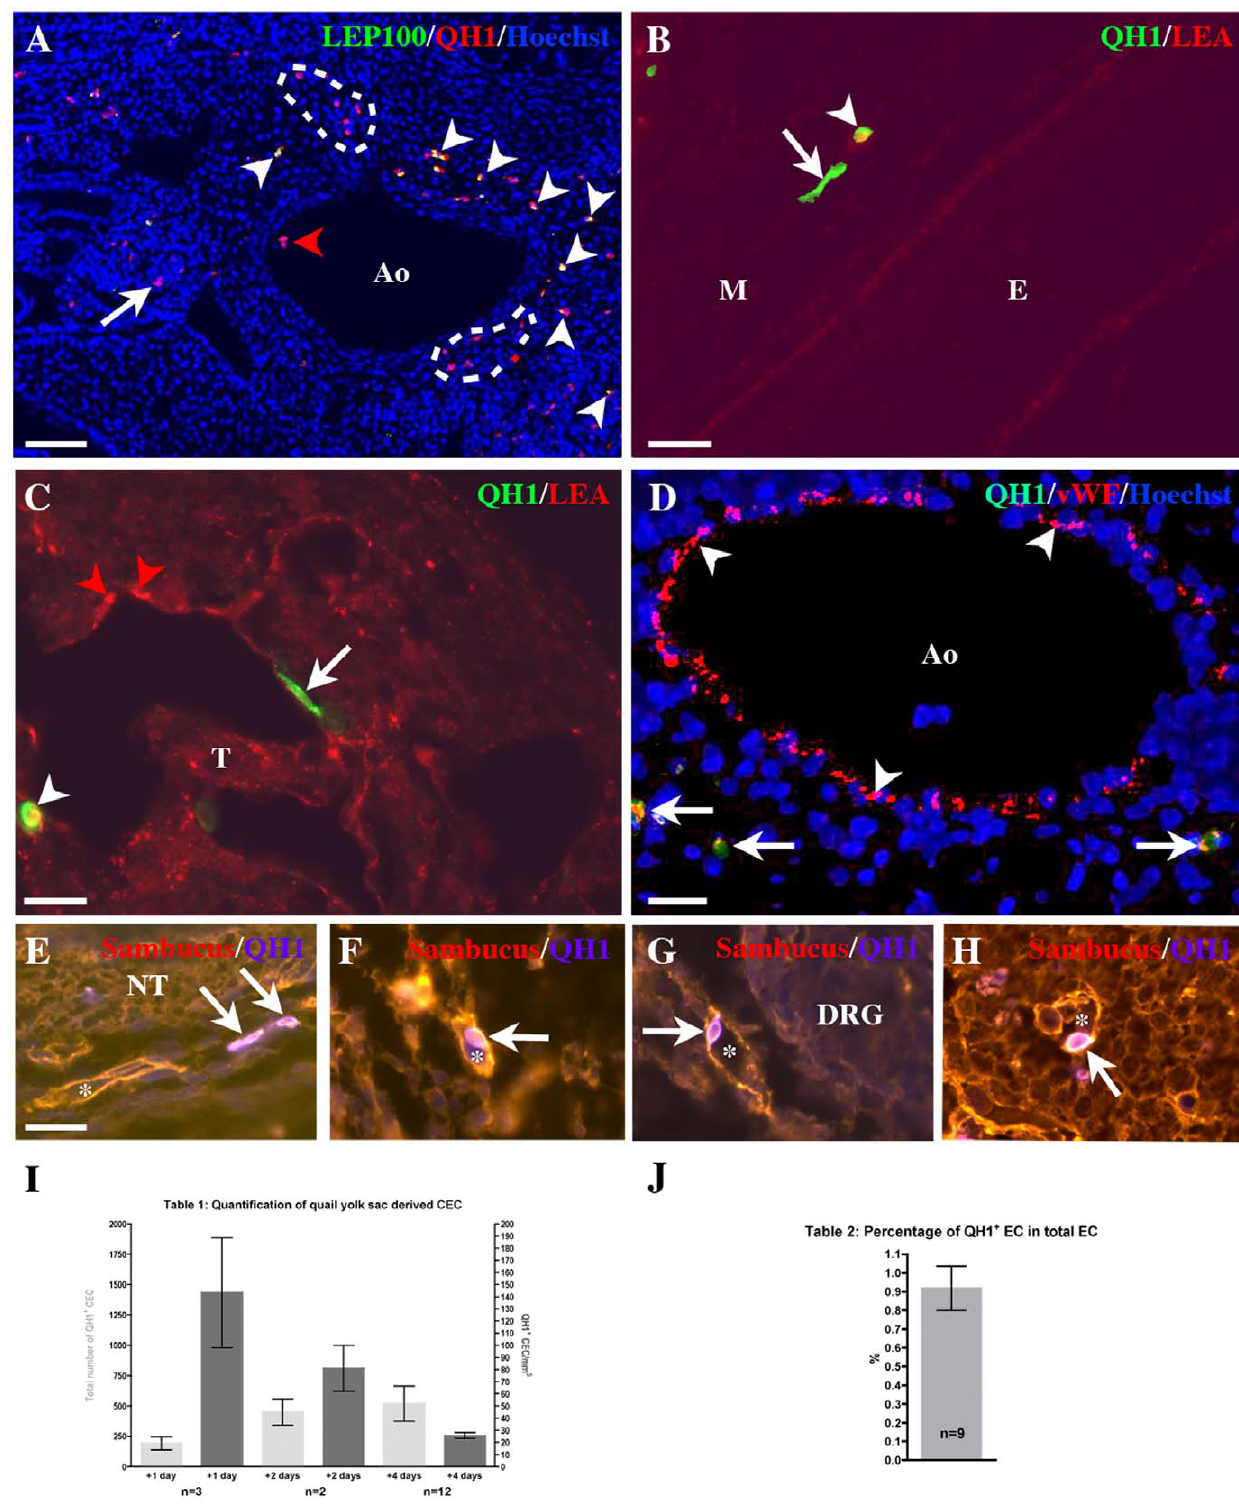
Figure 2. Identification of yolk sac-born QH1 + cells in E5.5 chick embryos isolated from yolk sac chimeras. Transverse sections. A) Around the aorta (Ao) a population of QH1 + cells was present: the majority is LEP 100 + macrophages (arrowheads), but some QH1 + /LEP100 2 CEC are present (dotted areas, arrow). QH1 + /LEP 100 2 CEC are observed in the circulation (red arrowhead). Bar: 40 mm B) Detection of an interstitial QH1 + / LEA 2 CEC (arrow) and of a QH1 + /LEA + macrophage (arrowhead) in the brain mesenchyme (M), close to the neural epithelium (E). Bar: 20 mm. C) A QH1 + /LEA 2 CEC (arrow) reaches the endocardium. Note the presence of one quail QH1 + /LEA + (white arrowhead) and two chick QH1 2 /LEA + (red arrowheads) macrophages. T: trabecula. Bar: 20 mm. D) Identification of three QH1 + /vWF + CEC in the periaortic mesenchyme (arrows). Note the vWF + endothelium of the aorta (Ao, arrowheads). Bar: 20 mm. E–H) Four examples of vessel-integrated (*) QH1 + /Sambucus nigra + quail CEC (arrows) in the